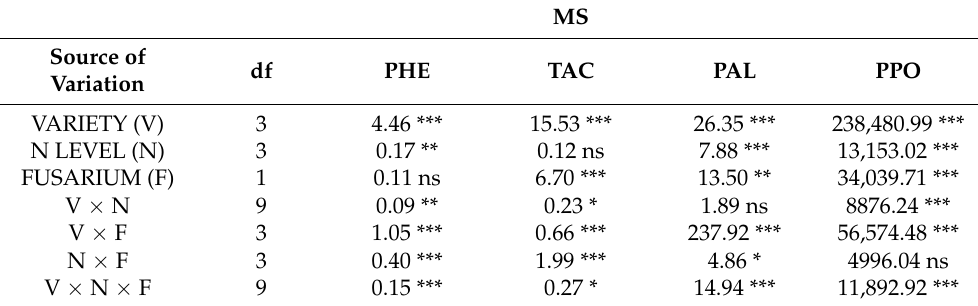
Table 4. Analysis of variance (three-way ANOVA) for measured biochemical parameters under different nitrogen and Fusarium treatments in spikes of four different winter wheat varieties in the 2019/2020 growing